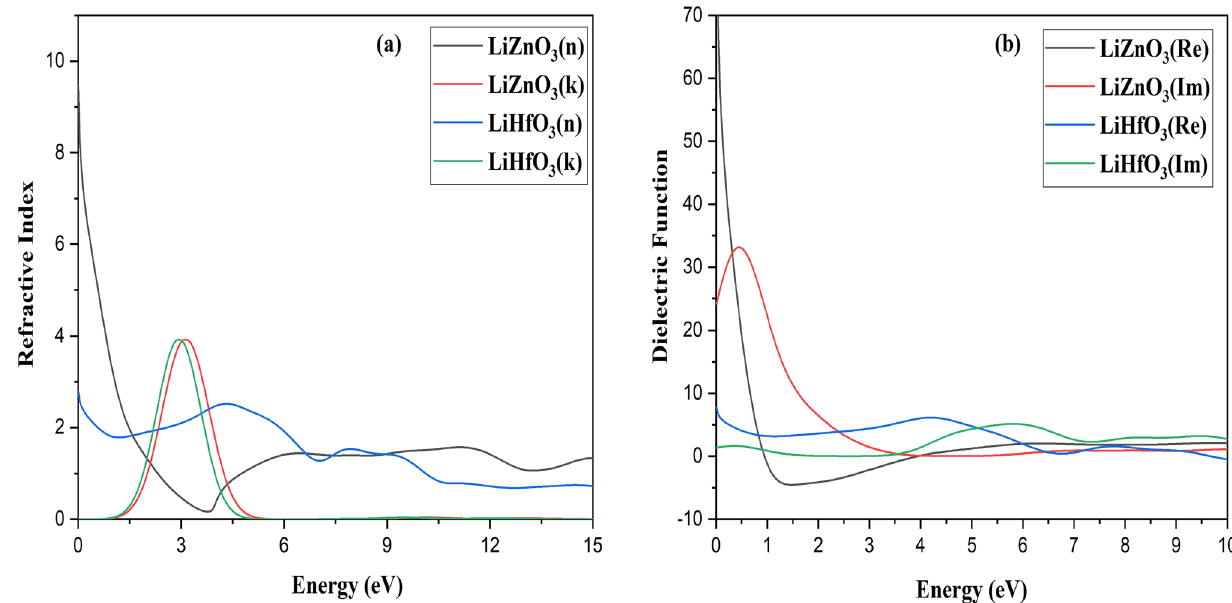
and LiHfO a Refractive Index b Dielectric 3 3